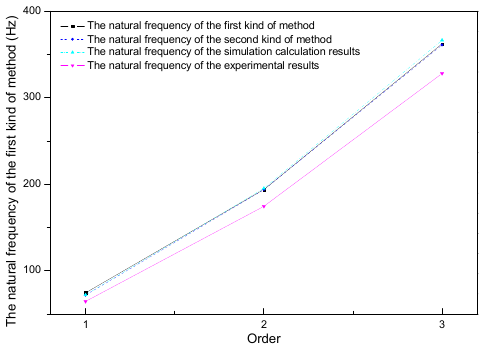
Figure 9. Comparison of theoretical calculation and simulation calculation results with experimental results of natural frequency of three-layer cylindrical shell.